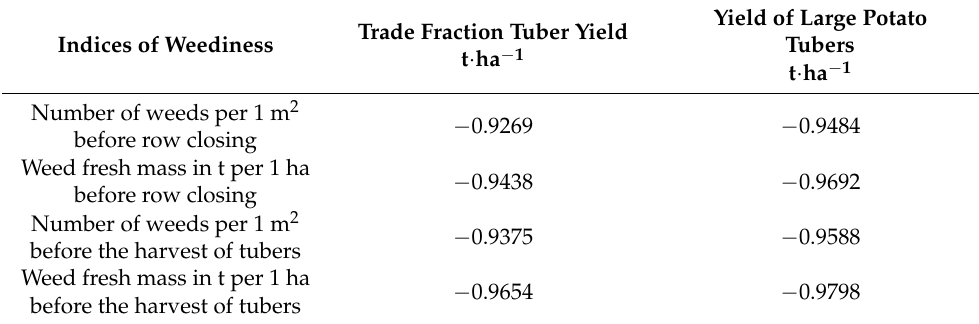
Table 6. Significant values of linear correlation coefficients between the weed number and the weight and yields of potato tubers (mean for the 3 years 2018–2020 and the cultivars Oberon and Malaga). Yield of Large Potato Trade Fraction Tuber Yield Indices of Weediness t · ha − 1